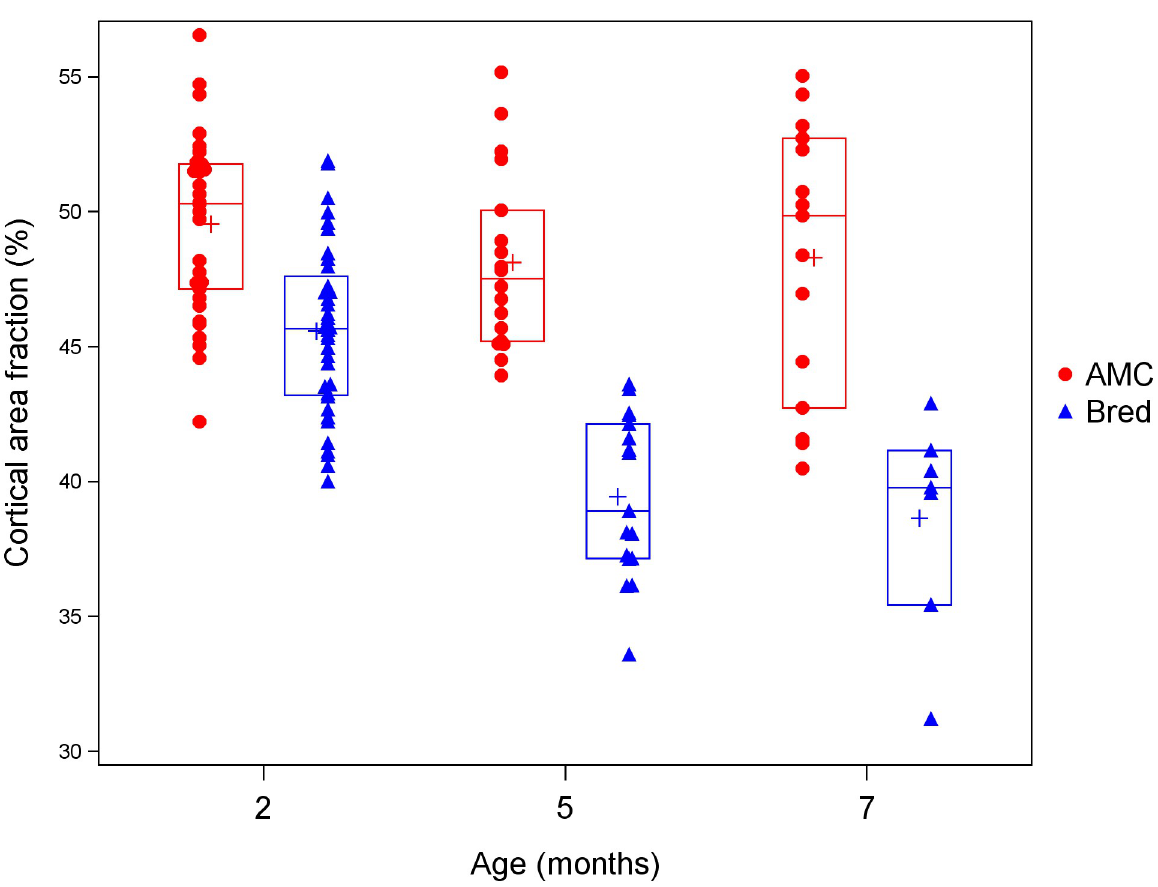
Fig 4. Effects of age and lactation on cortical area fraction among mice collected 3 weeks after weaning. Blue triangles denote bred mice, and red circles denote age-matched controls (AMC). Crosses denote means, while horizontal lines denote the 25th, 50th and 75th percentiles.